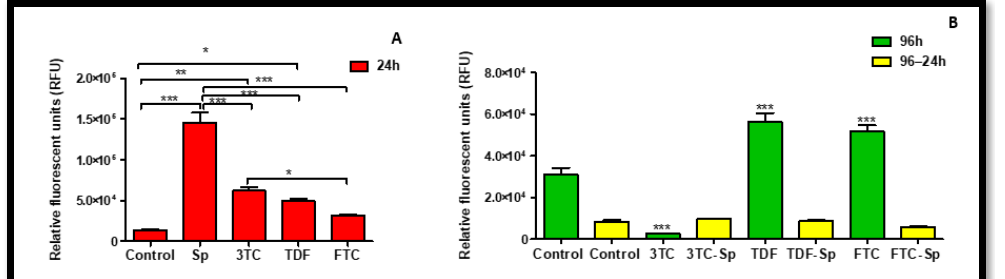
Figure 7. Intracellular ROS levels represented as relative light units (RLU) produced after H 2 DCF- DA staining in HepG2 cells. Intracellular ROS levels after exposure of HepG2 cells to ( A ) SP and HAART for 24 h, ( B ) HAART (96 h), and HAART (96 h) followed by SP (24 h); * p < 0.05, ** p < 0.005, *** p < 0.0001.